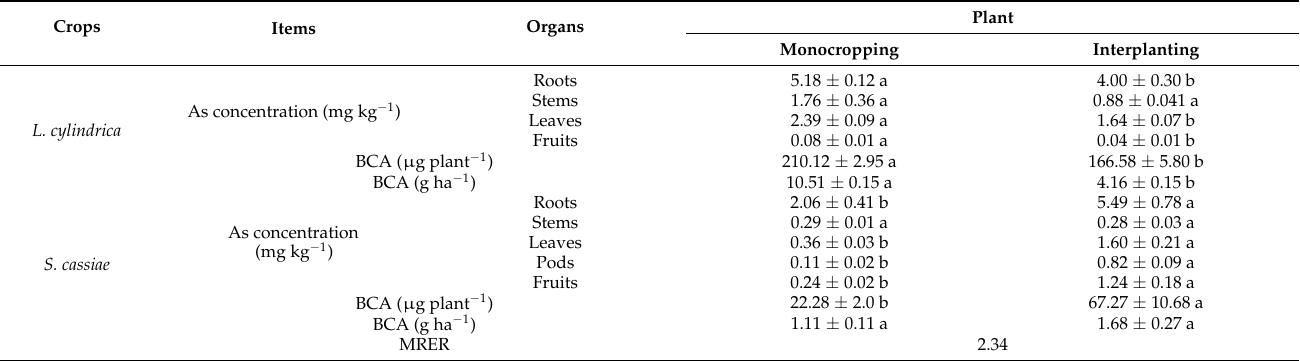
Table 2. Concentration of As in plant organs and BCA under the monocropping and intercropping systems in the field experiment.